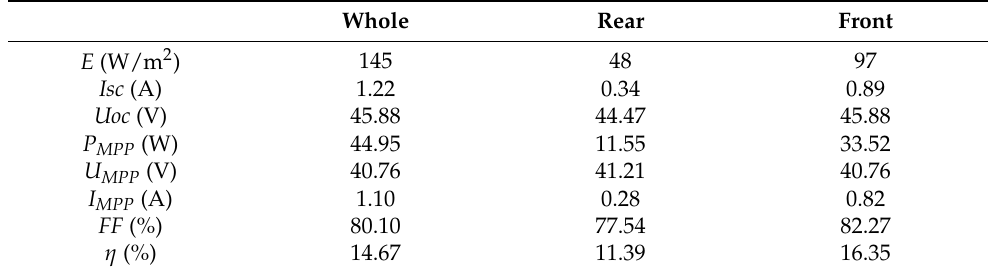
Table 13. The measurements results and calculations for 75 ◦ inclination of the module over the foil substrate, considering the values for the whole-module generation and its rear side generation.